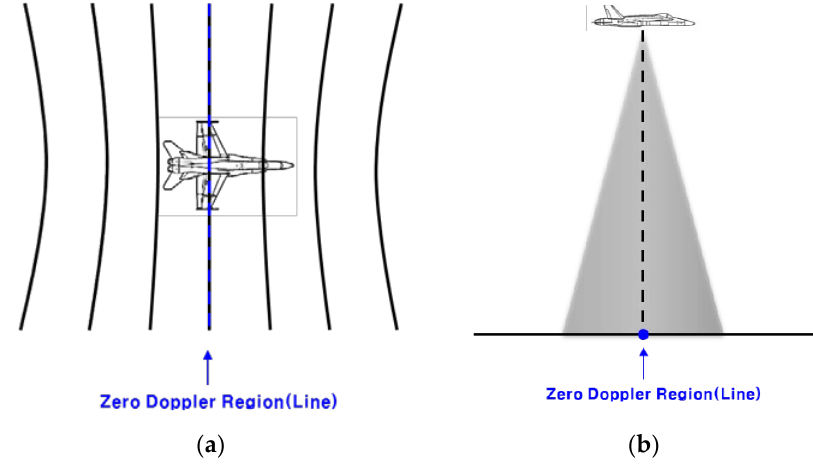
Figure 8. Isodop and zero Doppler region (line) of IRA on the aircraft: (a) top view; (b) side view.